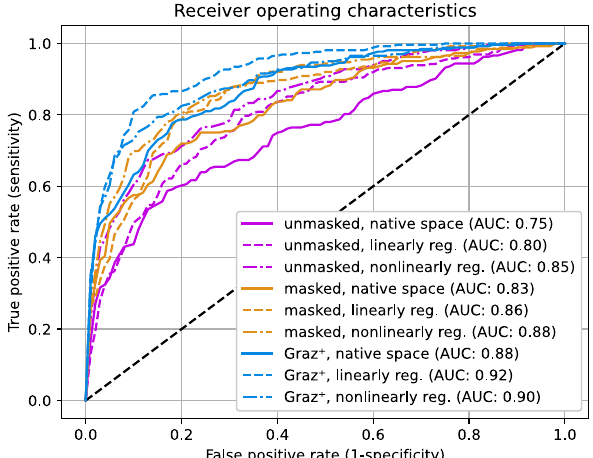
Figure 3. Comparison of mean receiver operating characteristics curves for all nine configurations. The Graz + models (blue) show higher values for the area under the curve (AUC in legend) compared to unmasked (purple) and masked (orange)